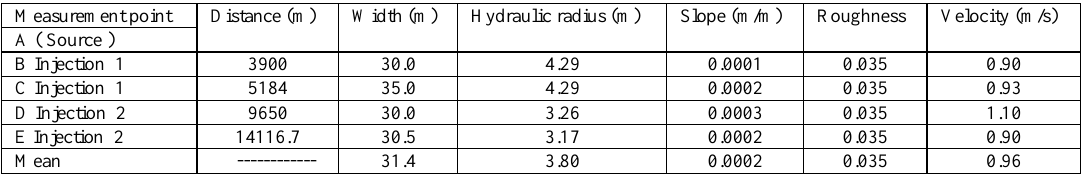
Table 1. Data on experimental parameters in the Rio Ure